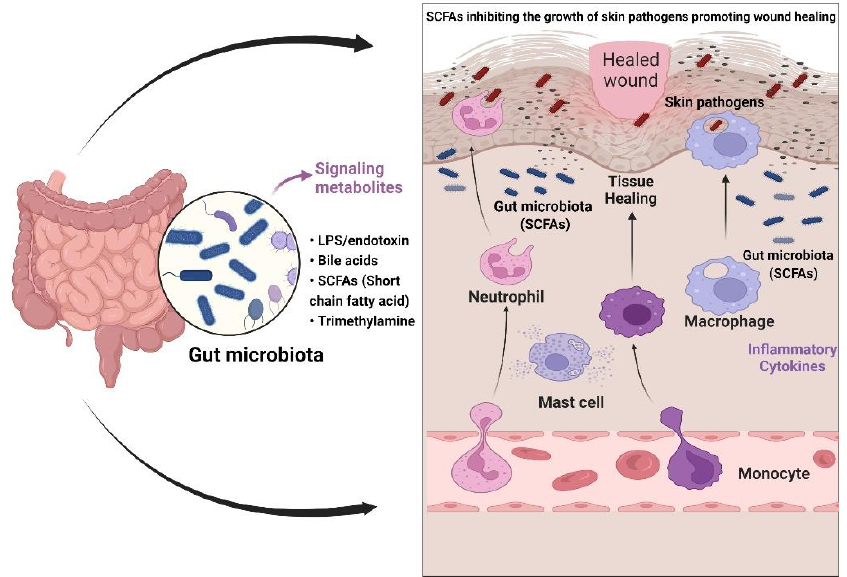
Figure 2. Gut – skin axis in wound healing. The gut microbiota stimulates the production of short-chain fatty acids (SCFAs) and carbohydrate metabolites that regulate the skin’s commensal bacteria. Secondary metabolites such as SCFAs regulate anti-inflammatory properties (the production of innate immune cells and cytokines), causing skin commensal bacteria to mediate effective antibacterial action against skin pathogens.